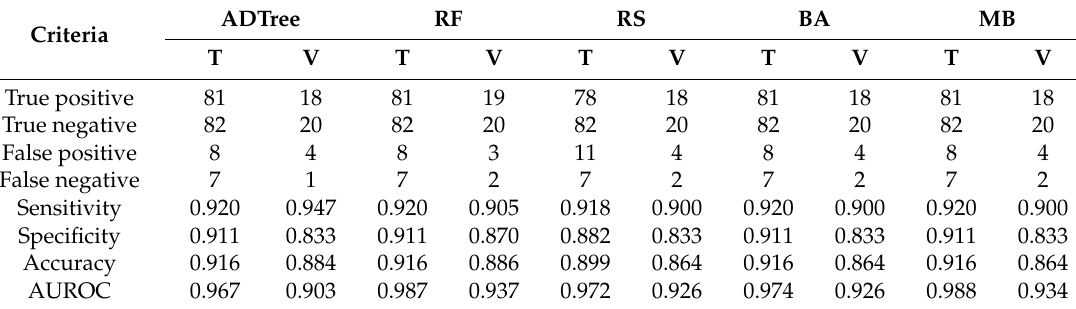
Table 8. Results of ensembles modeling by combination of 80%/20% and raster resolution of 20 m.